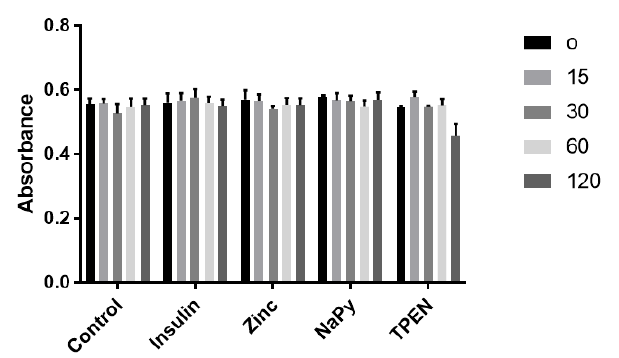
Figure 1. MTT assay of C2C12 cells following treatment with 10 nM of insulin, 20 µ M of zinc, 10 µ M of NaPy, and 100 µ M of TPEN for 0, 15, 30, 60, and 120 min.